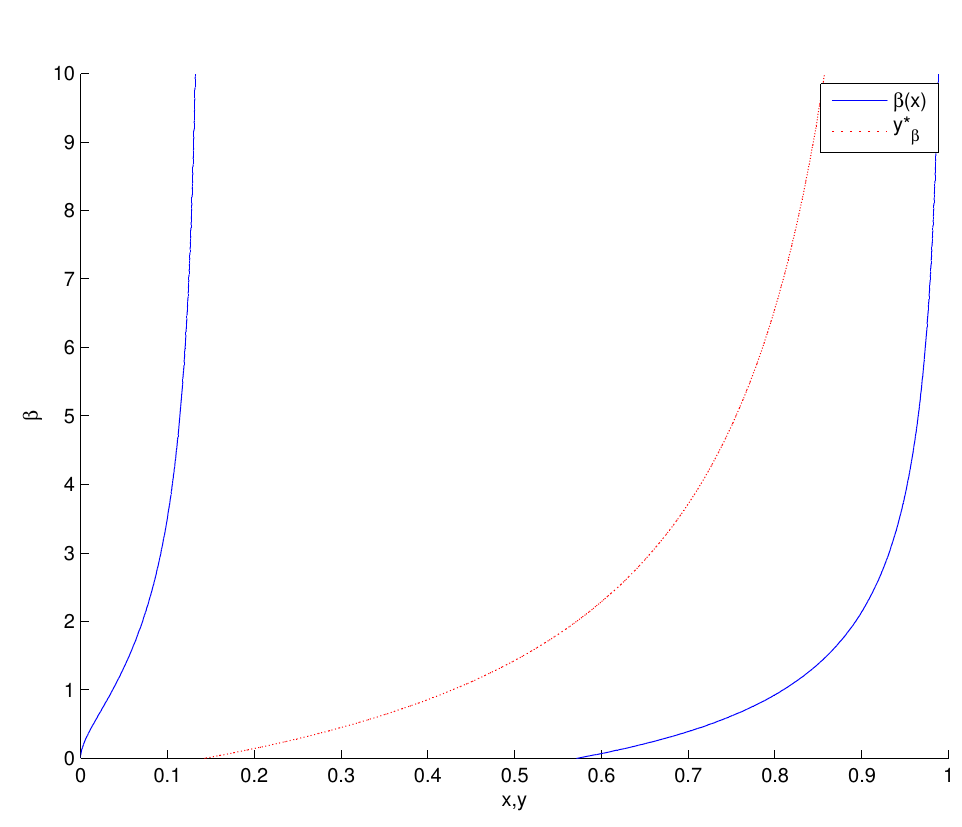
Figure 1. Newman’s